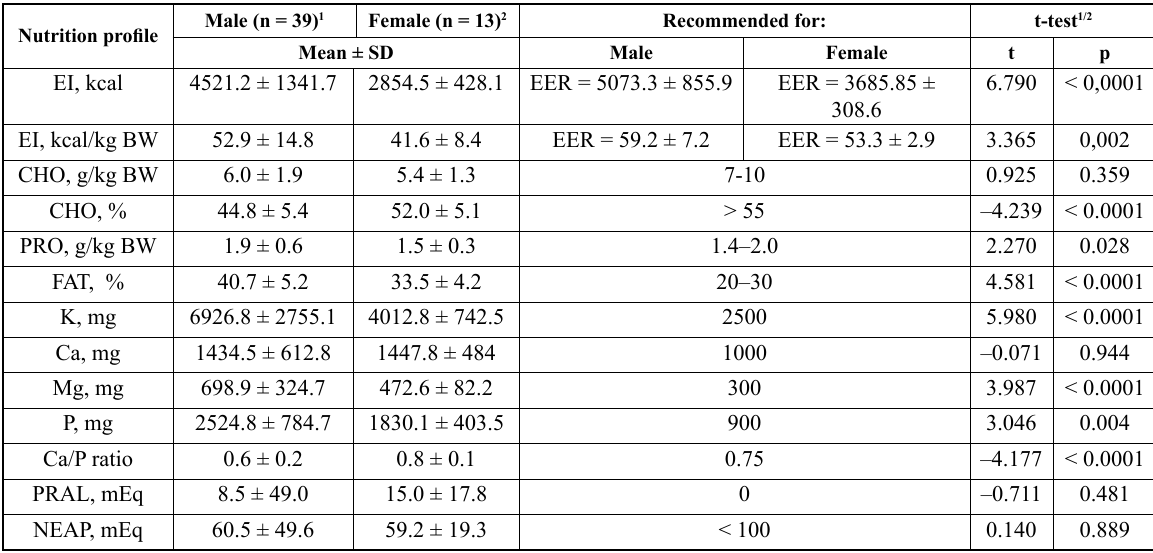
Table 2. Dietary intake of Lithuanian Olympic team basketball players (n = 52) Nutrition